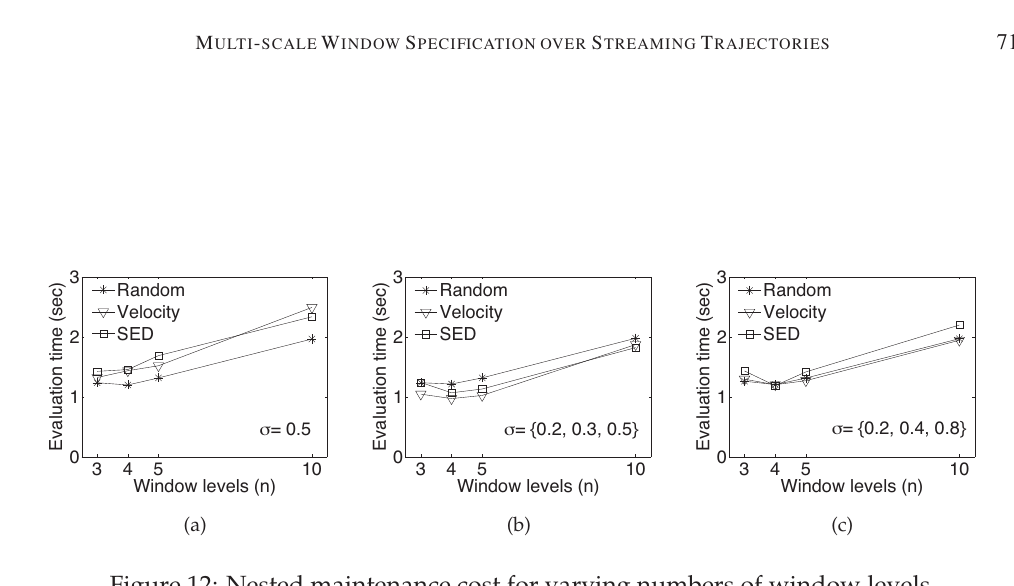
Figure 12: Nested maintenance cost for varying numbers of window levels.